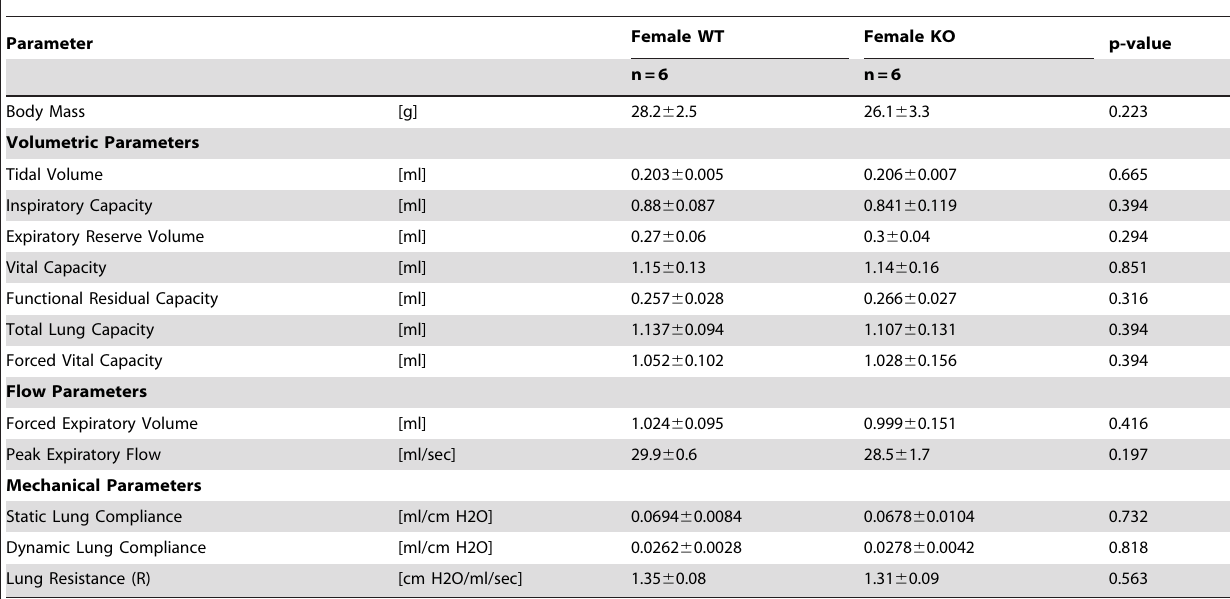
Table 2. Lung function parameters tested in NM1 knock-out and wild type mice.